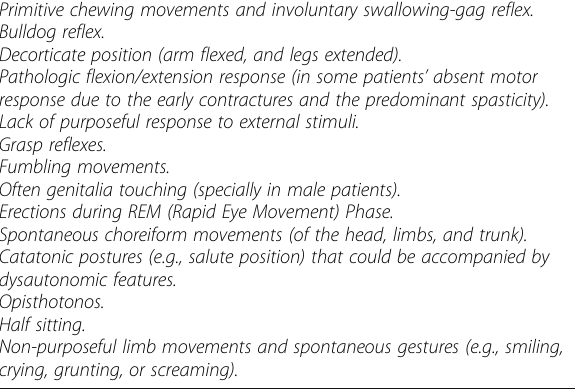
Table 1 Characteristics of a patient with a persistent vegetative status diagnosis (including atypical features) [15, 16] Primitive chewing movements and involuntary swallowing-gag reflex. Bulldog reflex. Decorticate position (arm flexed, and legs extended). Pathologic flexion/extension response (in some patients ’ absent motor Grasp reflexes. Fumbling